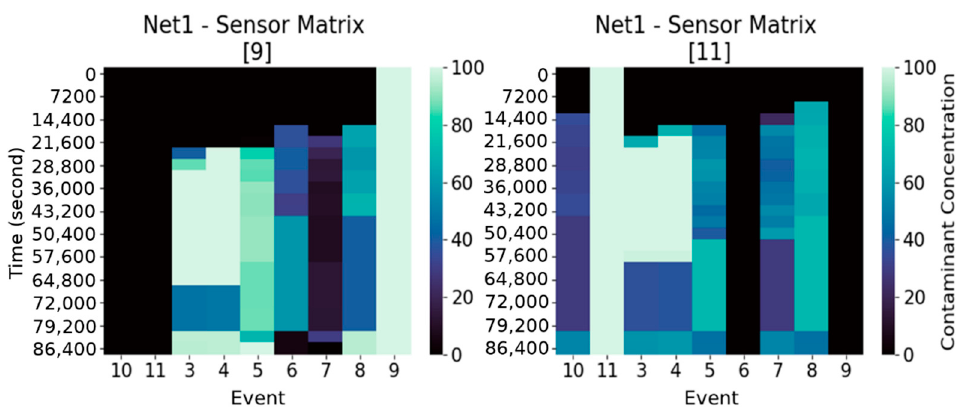
Figure 2. Sensor matrices S 9 and S 11 for sensors deployed respectively at locations, i.e., Node 9 ( left ) and Node 11 ( right ).